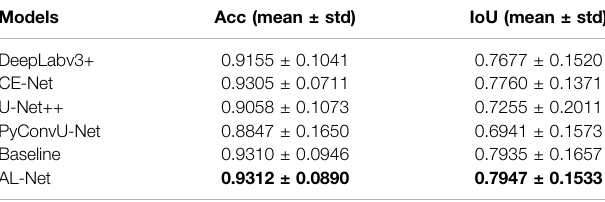
Bold represents the best result.